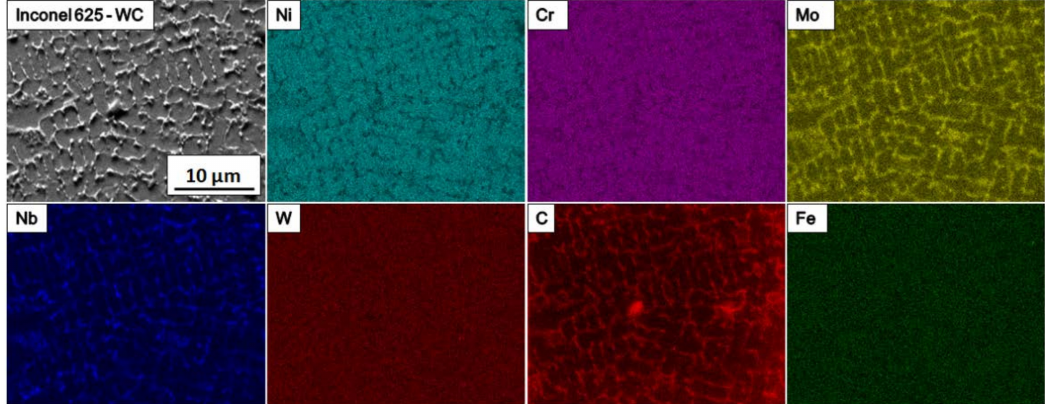
Figure 5. SEM-EDS elemental maps—segregation of the elements in the metal matrix composite (MMC)